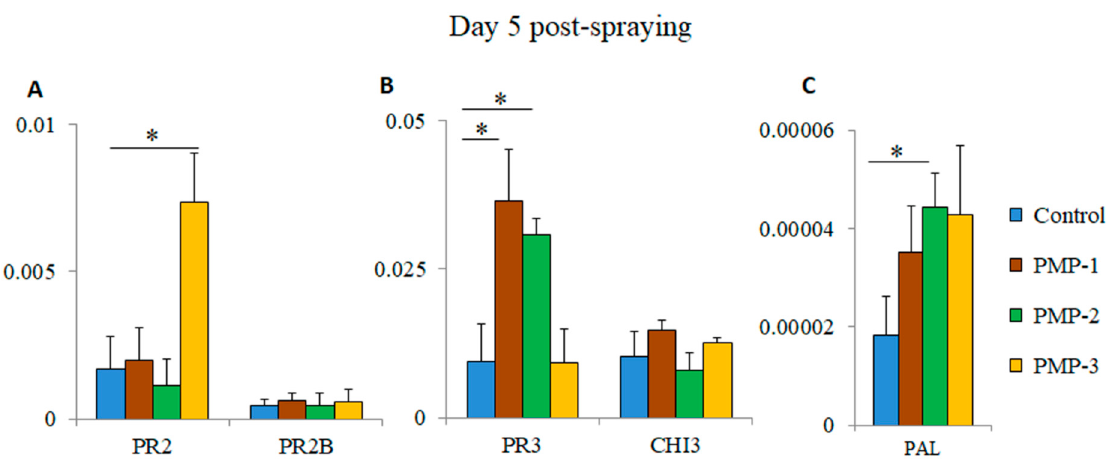
Figure 7. Expression of ( A ) pathogenesis-related protein 2 (PR2) and pathogenesis-related protein 2B (PR2B), ( B ) pathogenesis-related protein 3 (PR3) and acidic endochitinase (CHI3), and ( C ) phenylalanine ammonia-lyase (PAL) genes in the leaves of tomato plants ( n = 4 per group) 5 days post-spraying with the PMP materials. Error bars denote ± STDEV (* p -value < 0.05).